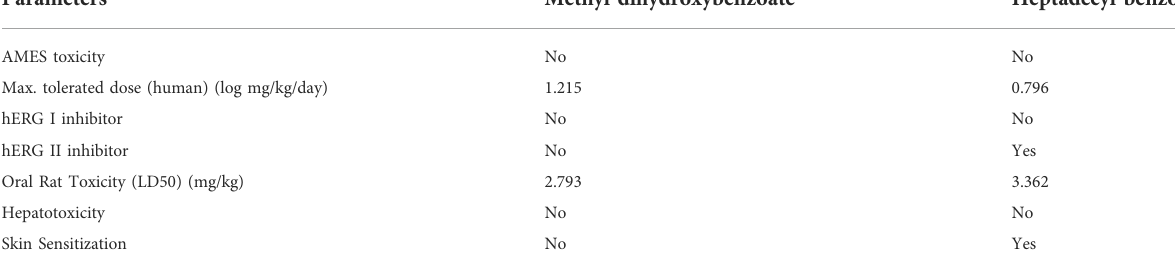
TABLE 4 Toxicity pro fi le of methyl dihydroxybenzoate and heptadecyl benzoate.